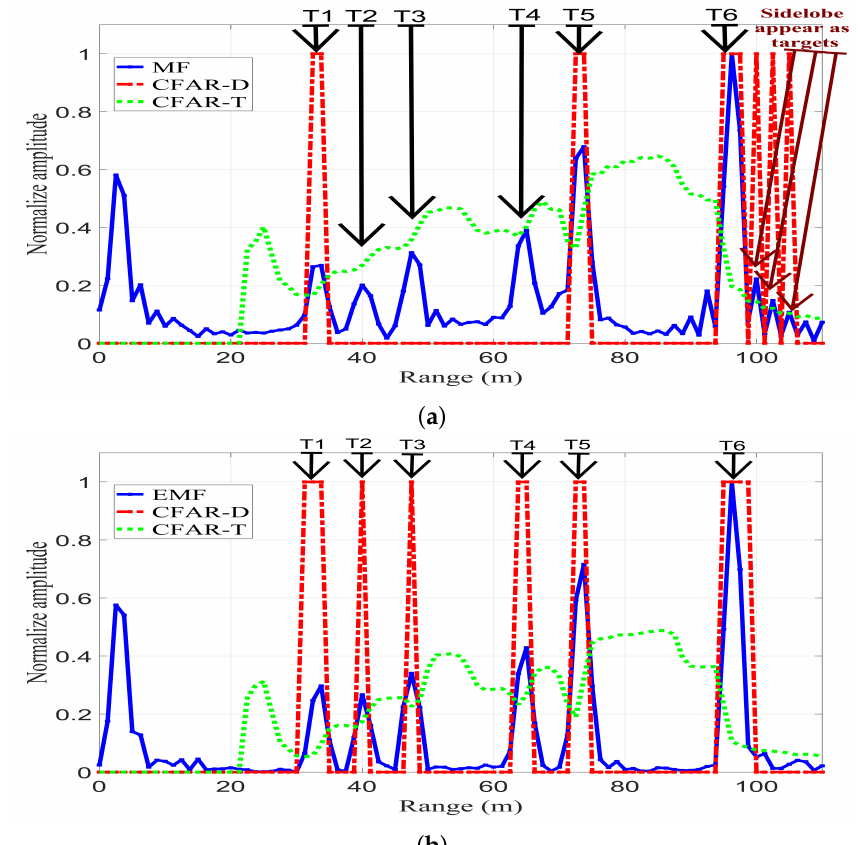
Figure 24. CFAR detection, with P fa = 10 − 6 , for MF and the proposed EMF: ( a ) MF. ( b ) Proposed